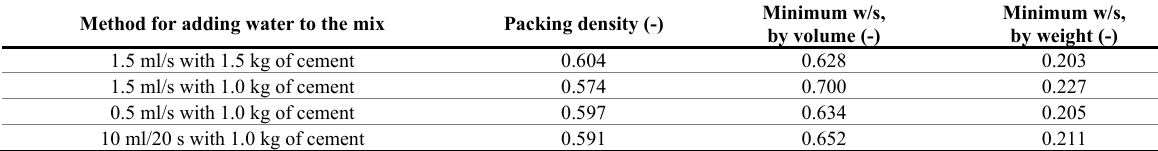
Table 6. Packing density and water demand results obtained from the mixing energy method